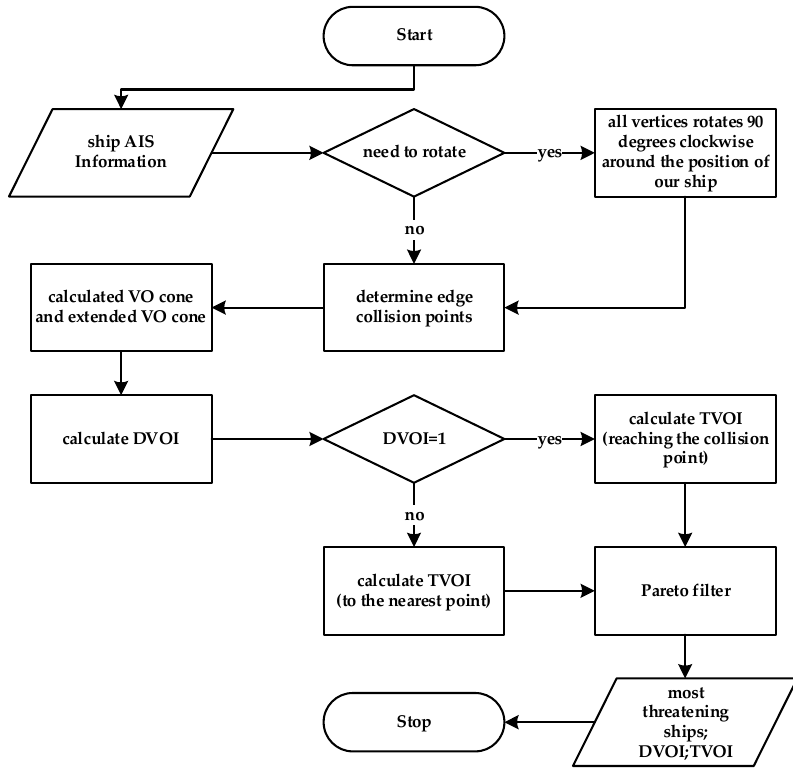
Figure 13. The main steps of the algorithm.